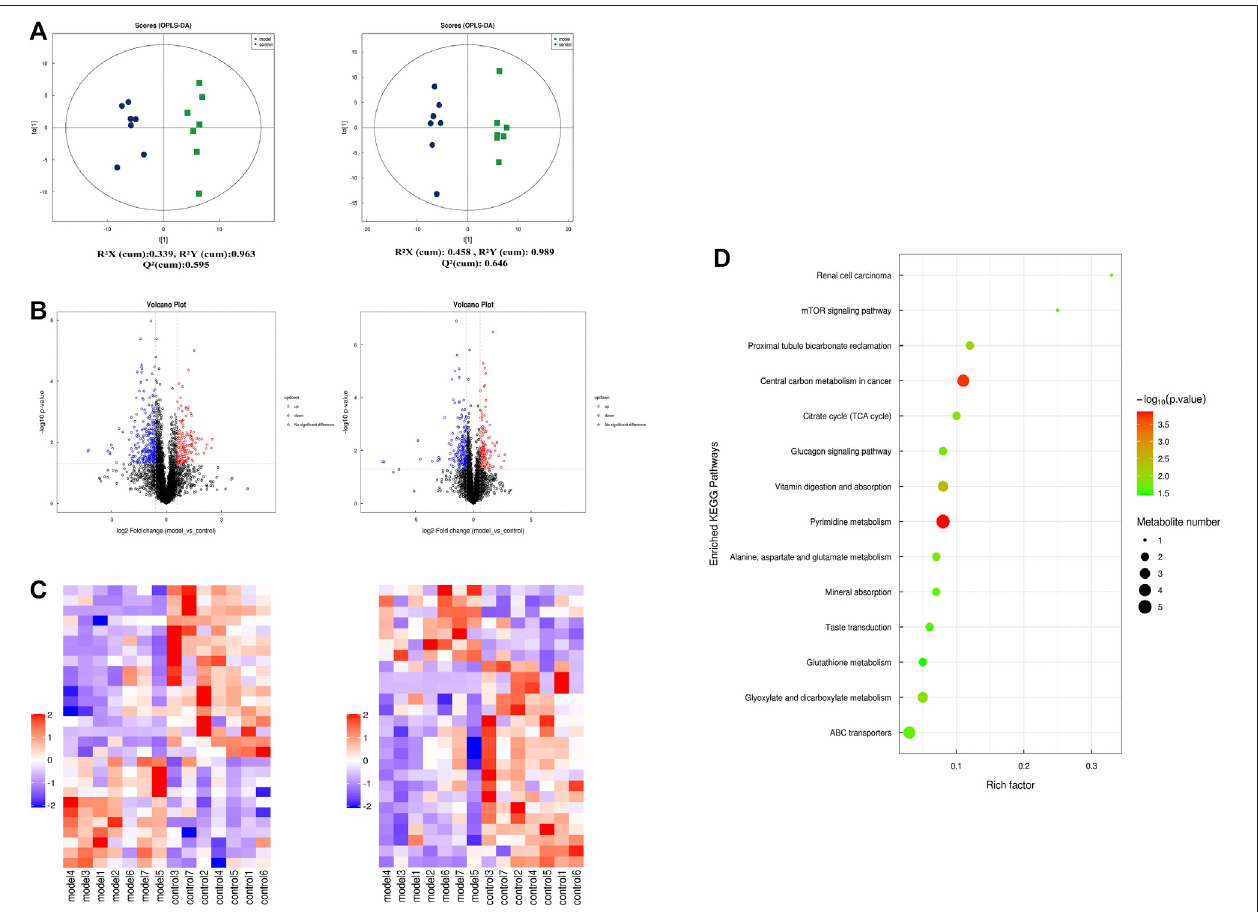
FIGURE 4 | Untargeted plasma metabolome detection. (A) The OPLS-DA scatter plot under positive and negative ion modes; (B) Volcano map of different metabolites in positive and negative ion mode. (The up-regulated differential metabolites were red, FC > 1.5, p value < 0.05; The down-regulated differential metabolites were blue, FC < 0.67, p value < 0.05.) (C) The clustering results of hierarchical cluster analysis based on the signi fi cantly different metabolites between groups under positive and negative modes. (D) Enriched KEGG pathways based on signi fi cant different metabolites between control group ( n = 7) and model group ( n =